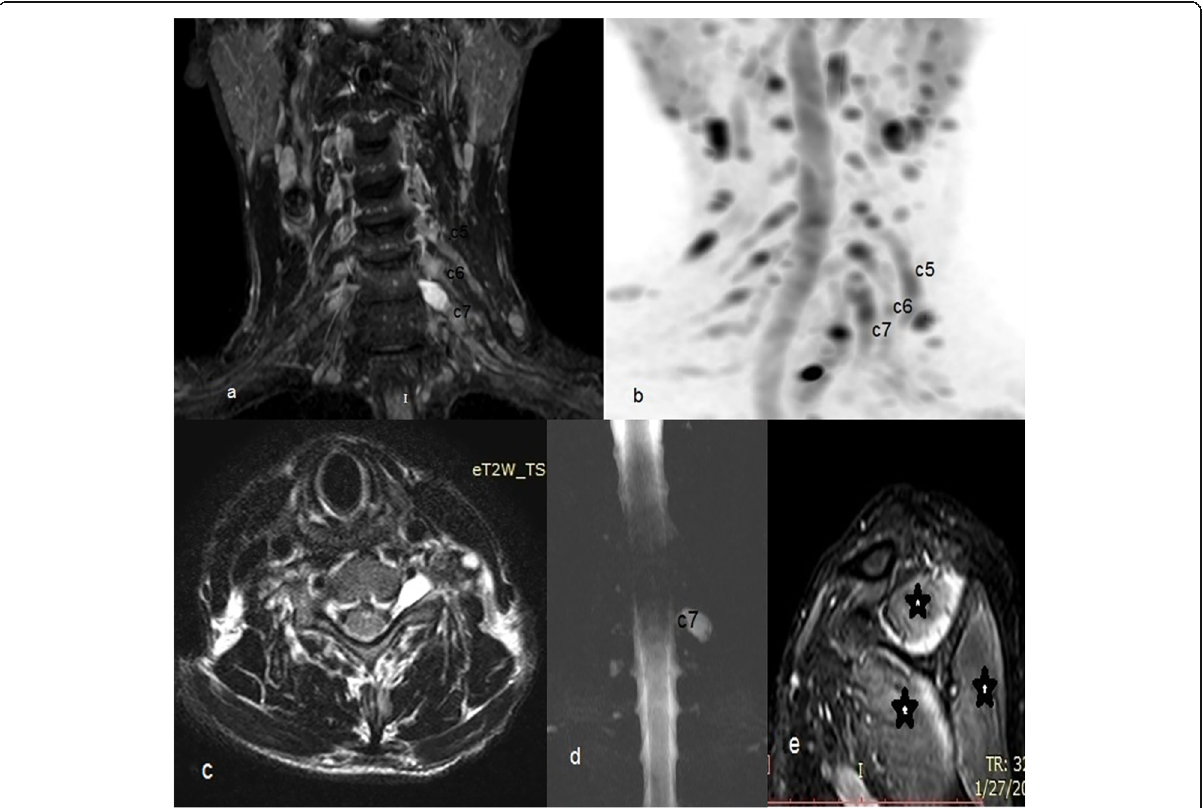
Fig. 2 A 55-year-old male patient presented with left side traumatic brachial plexus injury following MCA 6 months before imaging. a MIP processing of coronal STIR shows thickened left C5 and C6 with increased signal and pseudomeningocele at left C7. b MIP of coronal DWIBS shows thickened left C5, C6, and C7 with a restricted signal. c Axial T2WI and d radial myelography showing pseudomeningocele formation at left C7. e Sagittal STIR shows edema of the left rotator cuff muscles (stars). Intraoperative data are ruptured left C5 and C6 with avulsed C7